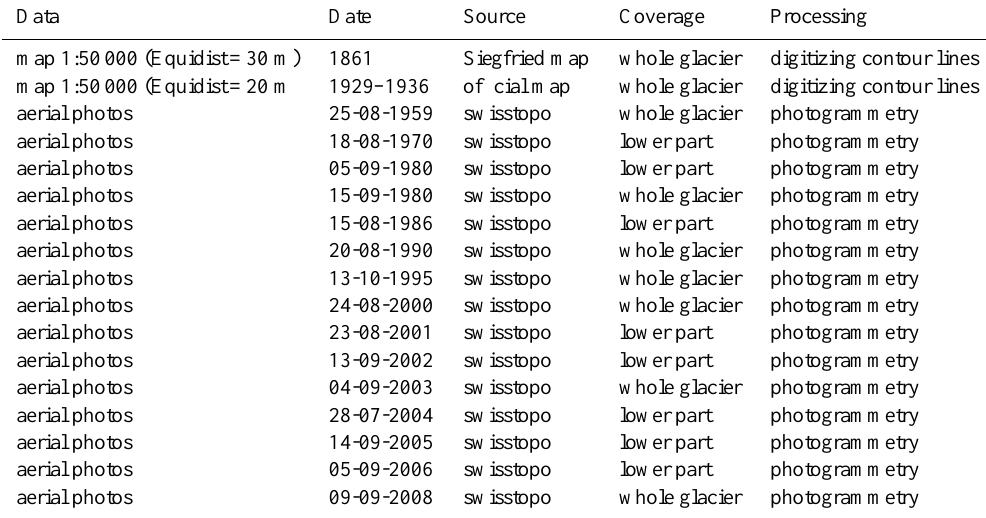
Table 1. Database used to generate digital elevation models (DEMs) of Triftgletscher.